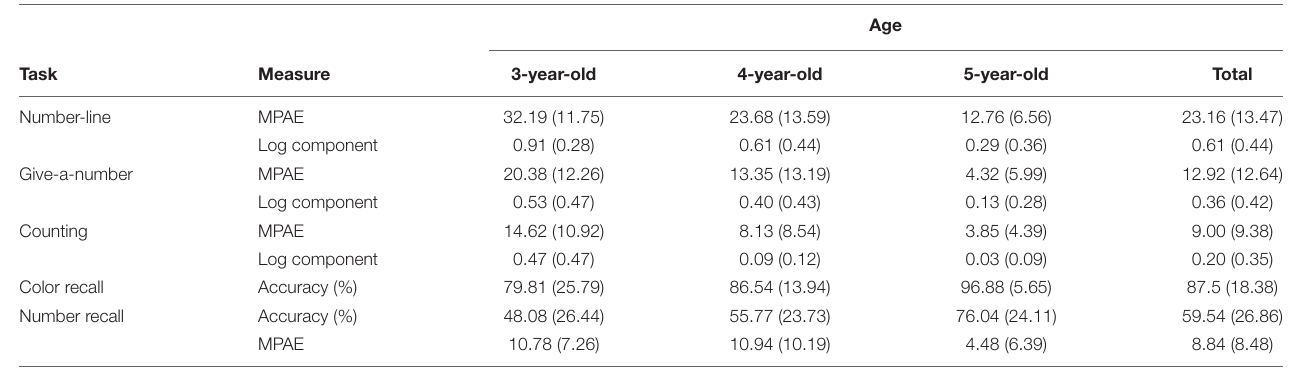
TABLE 1 | Mean performance (and SDs) by tasks for each age